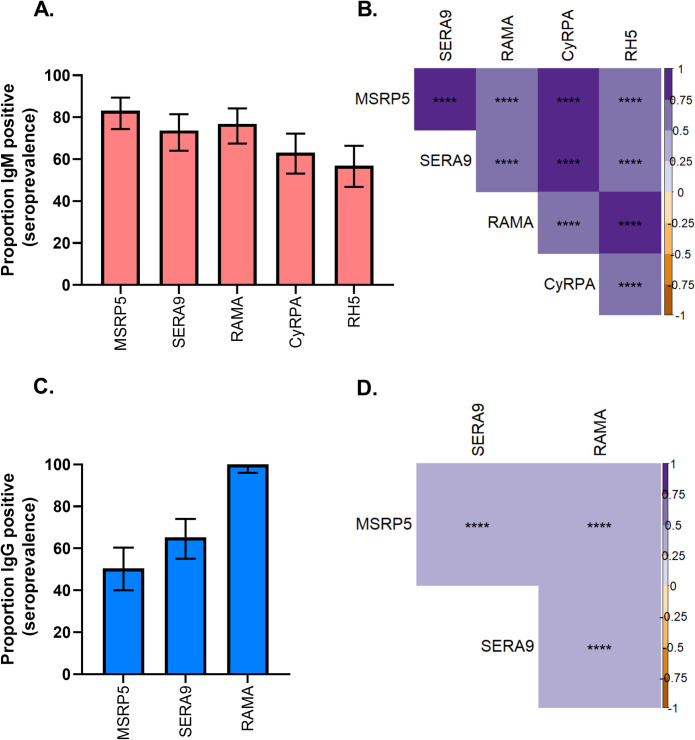
Prevalence and correlation of IgM, and IgG specific for merozoite antigens in children with P. falciparum malaria.PfMSRP5, PfSERA9, PfRAMA, PfCyRPA and PfRH5 -specific IgM and IgG responses in children with acute P. falciparum malaria were measured by ELISA. Percent of samples with merozoite antigen-specific IgM (red), and IgG (blue), and their 95% confidence intervals (error bars) are shown in panels A. and C., respectively. Spearman’s correlation of antibody responses between the antigens is shown for IgM (B.) and IgG (D.). Statistical significance is represented by asterisks (p<0.05 (*), p<0.01 (**), p<0.001 (***), p<0.0001 (****)) and color represents the strength and direction of correlation as shown in the key.